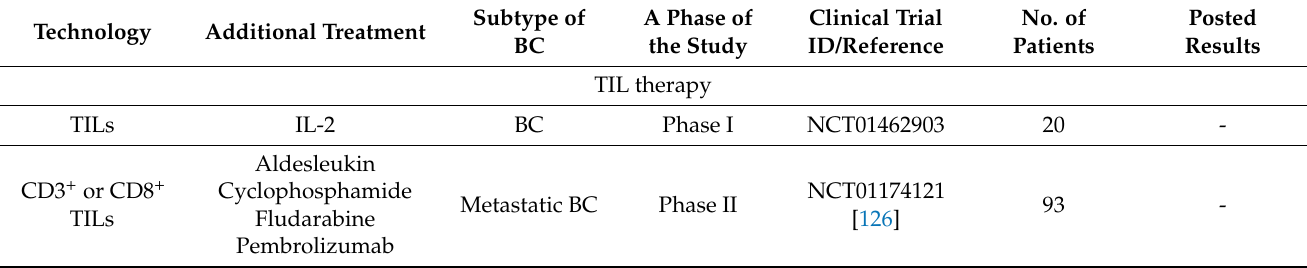
Table 3. Overview of the clinical trials in breast cancer with the application of the TILs, TCR-T cells and NK cells.